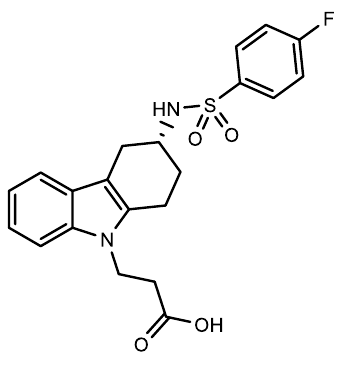
Figure 10. Structure of ramatroban ( 14 ).